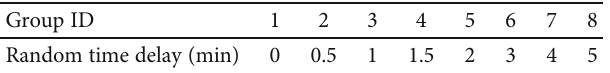
Table 5: Random time delay of the ground-based mode for